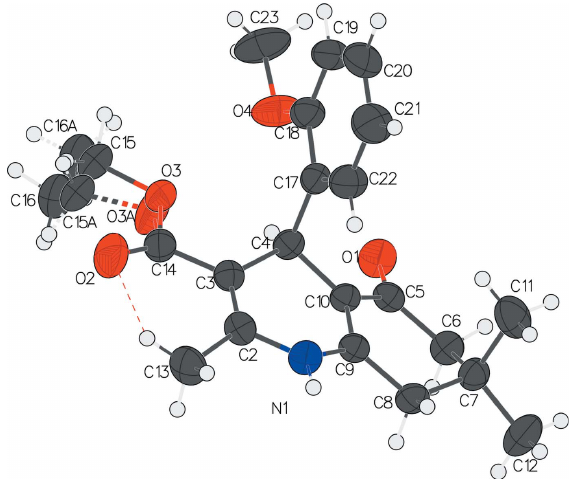
Figure 1 The asymmetric unit of compound I showing the atom-labeling scheme. Displacement ellipsoids are drawn at the 50% probability level. The intramolecular hydrogen bond between C13—H13 B and O2 is shown as a dashed line. The crystal disintegrated below 273 K and the X-ray structure was acquired at room